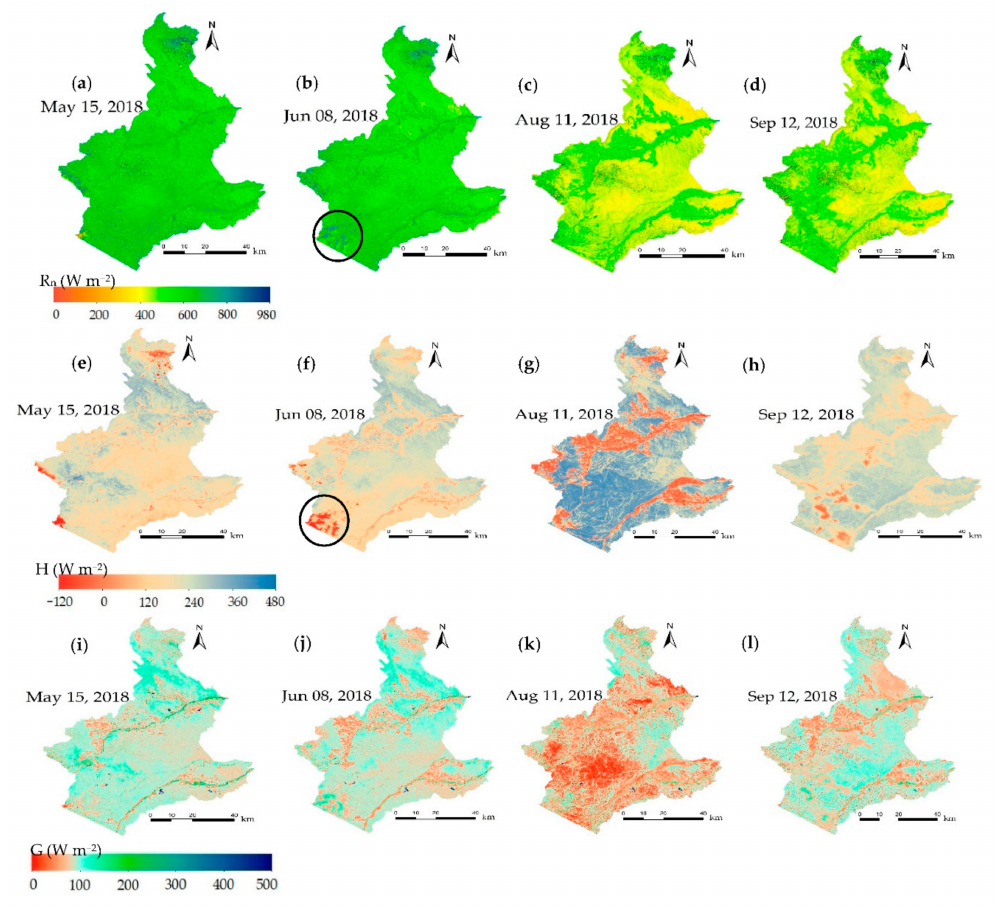
Figure 8. Spatio-temporal distribution of METRIC estimated instantaneous net Radiation (Rn, W m − 2 ) ( a – d ), sensible heat (H, W m − 2 ) ( e – h ) and soil heat (G, W m − 2 ) ( i – l ) on 15 May 2018, 2 July 2018, 11 August 2018 and 12 September 2018. The Black circled portion in some images represent the cloud